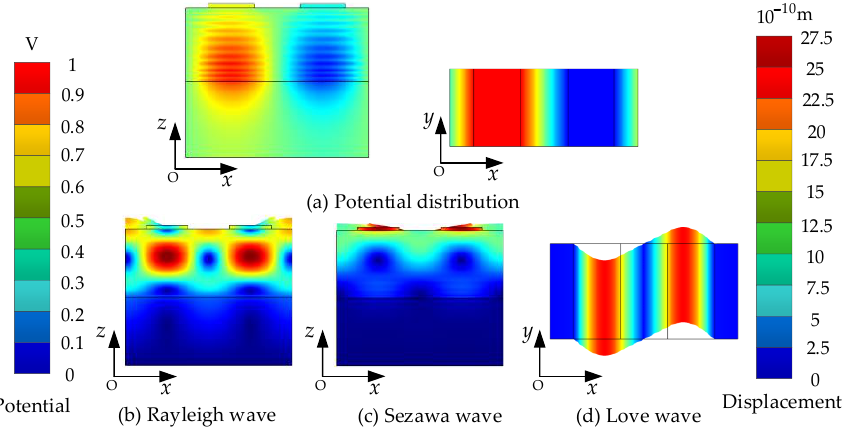
Figure 4. Potential, Rayleigh, Sezawa, and Love wave distribution of the phonon piezoelectric device. ( a ) Potential distribution; ( b ) Rayleigh wave distribution; ( c ) Sezawa wave distribution; ( d ) Love wave distribution.